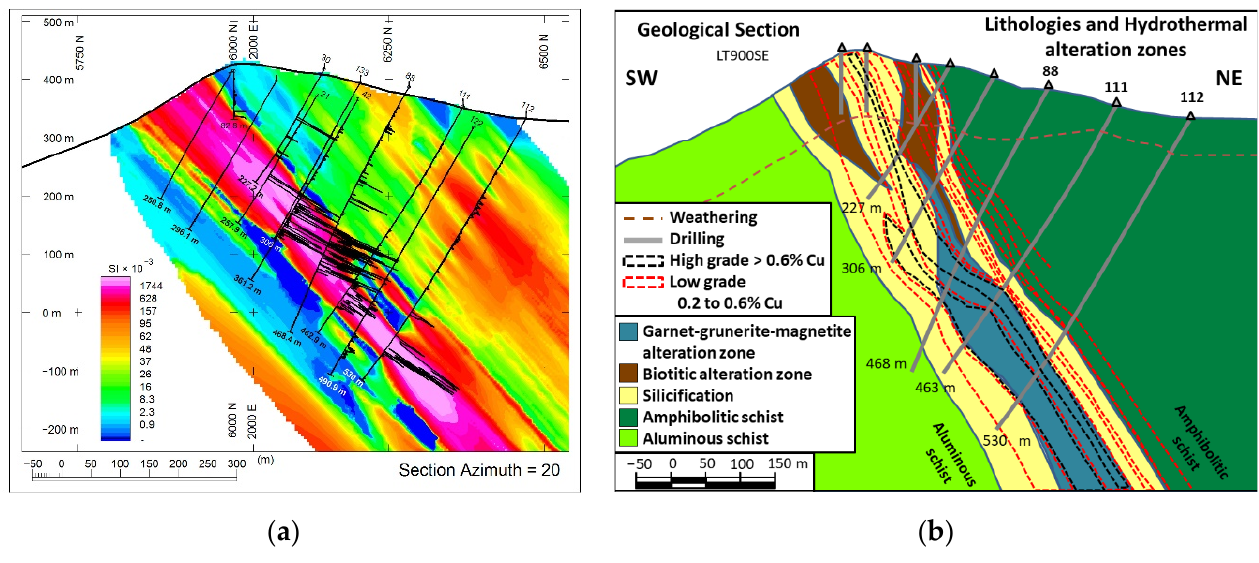
Figure 20. Good correlation between ( a ) magnetic susceptibility model represented with magnetic susceptibility measured on drill cores (black line profiles along drill hole lines). ( b ) High-grade orebodies with values higher than 0.6% copper (dashed black lines) represented in the geological section with the host rocks, hydrothermal alteration zones and mineralized zones (Modified from Vale S.A. [42]). The location of sections is shown in Figures 3 and 6.